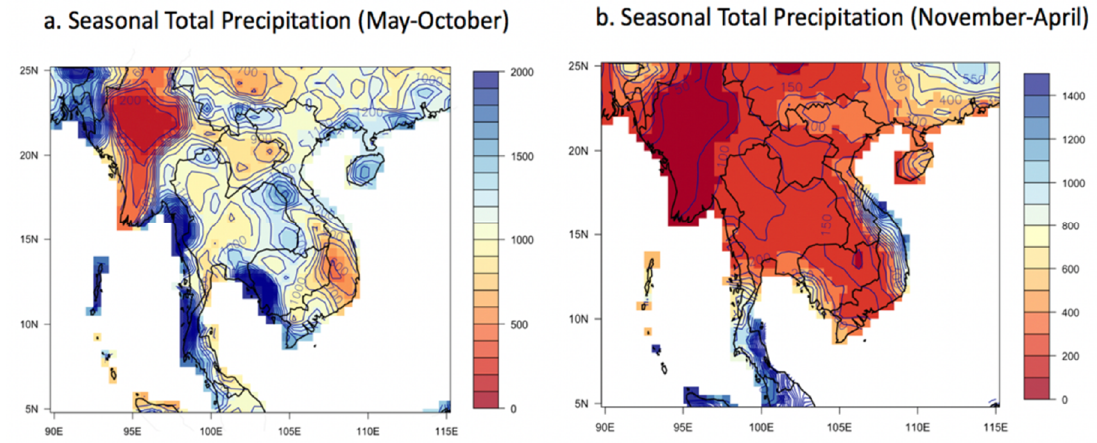
Figure 4. Average precipitation (mm) during the ( a ) wet and ( b ) dry seasons (1979–2018).